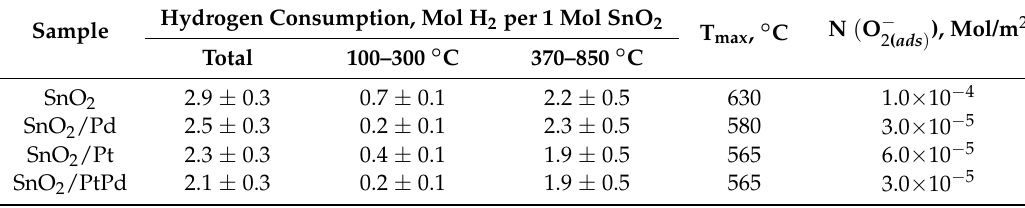
Table 3. Results of the TPR-H 2